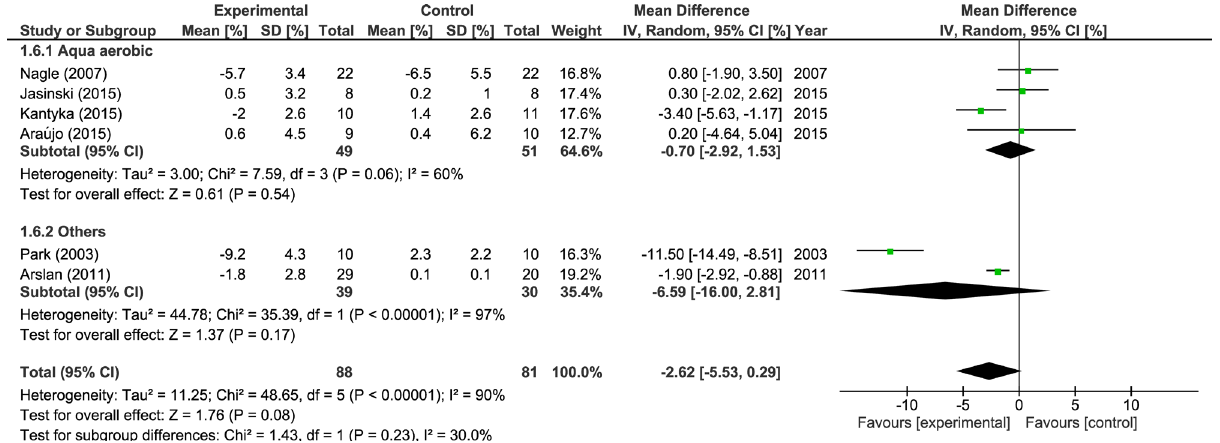
Figure 3. Assessment of the effect of various types of aerobics on fat mass percentage.